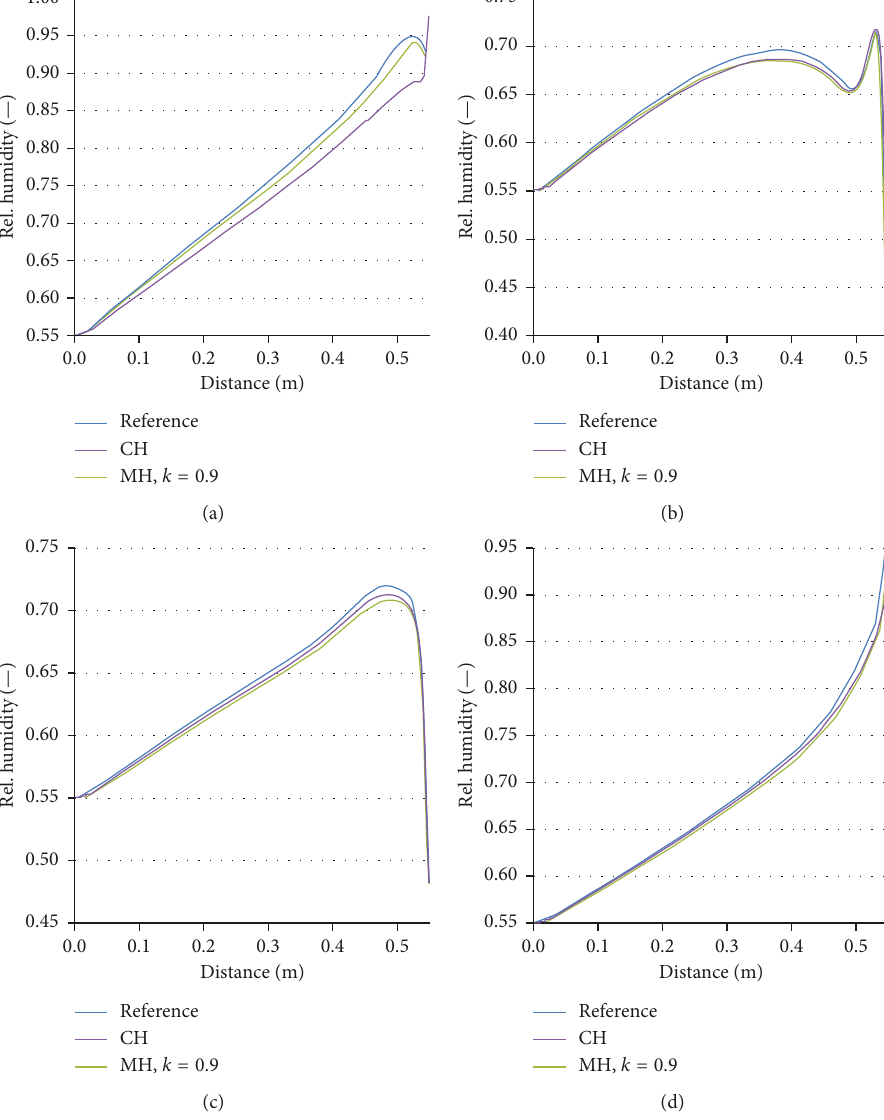
Figure 7: Comparison of relative humidity profiles: (a) January 15, 12:00, (b) April 15, 12:00, (c) July 15, 12:00, and (d) October 15, 12:00, of the reference year.